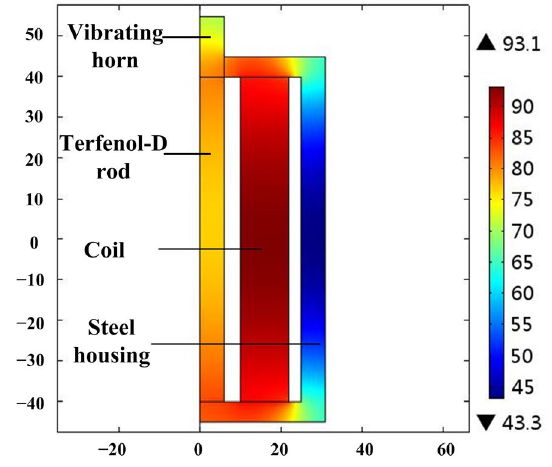
Figure 5. Temperature distribution of the GMT.